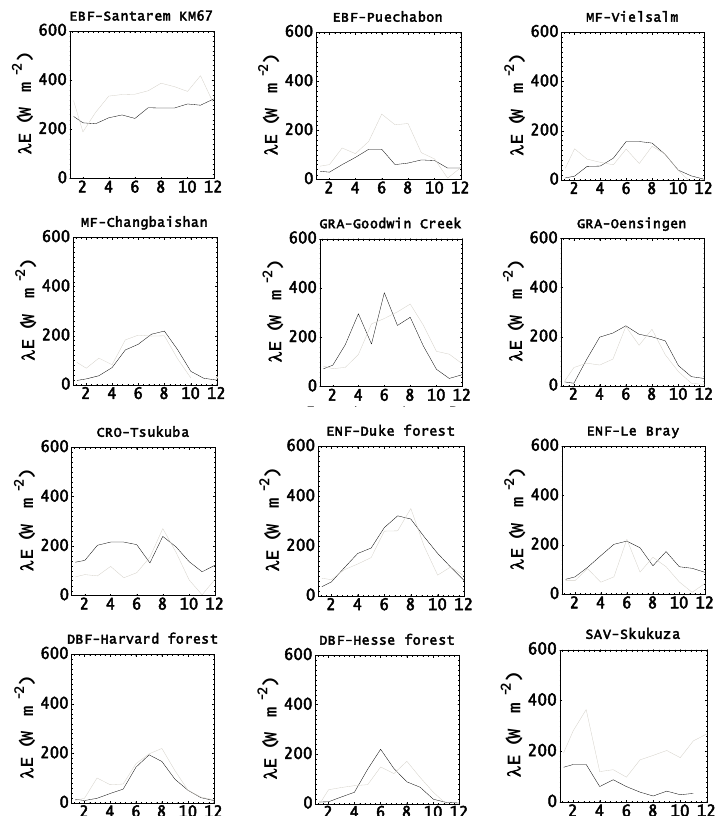
Figure 5. S atellite (grey) and tower (black) time series of monthly average 13:30 hour latent heat Figure 5. Satellite (grey) and tower (black) time series of monthly average 13:30 latent heat flux, λE , for a selection of sites for 2003. The flux, λE, for a selection of sites for 2003. The numbers in the x-axis are the month numbers numbers on the x axis are the month numbers, indicating January ( month number 1) to December (month number 12). indicating January (as month number 1) to December (as month number 12). 850